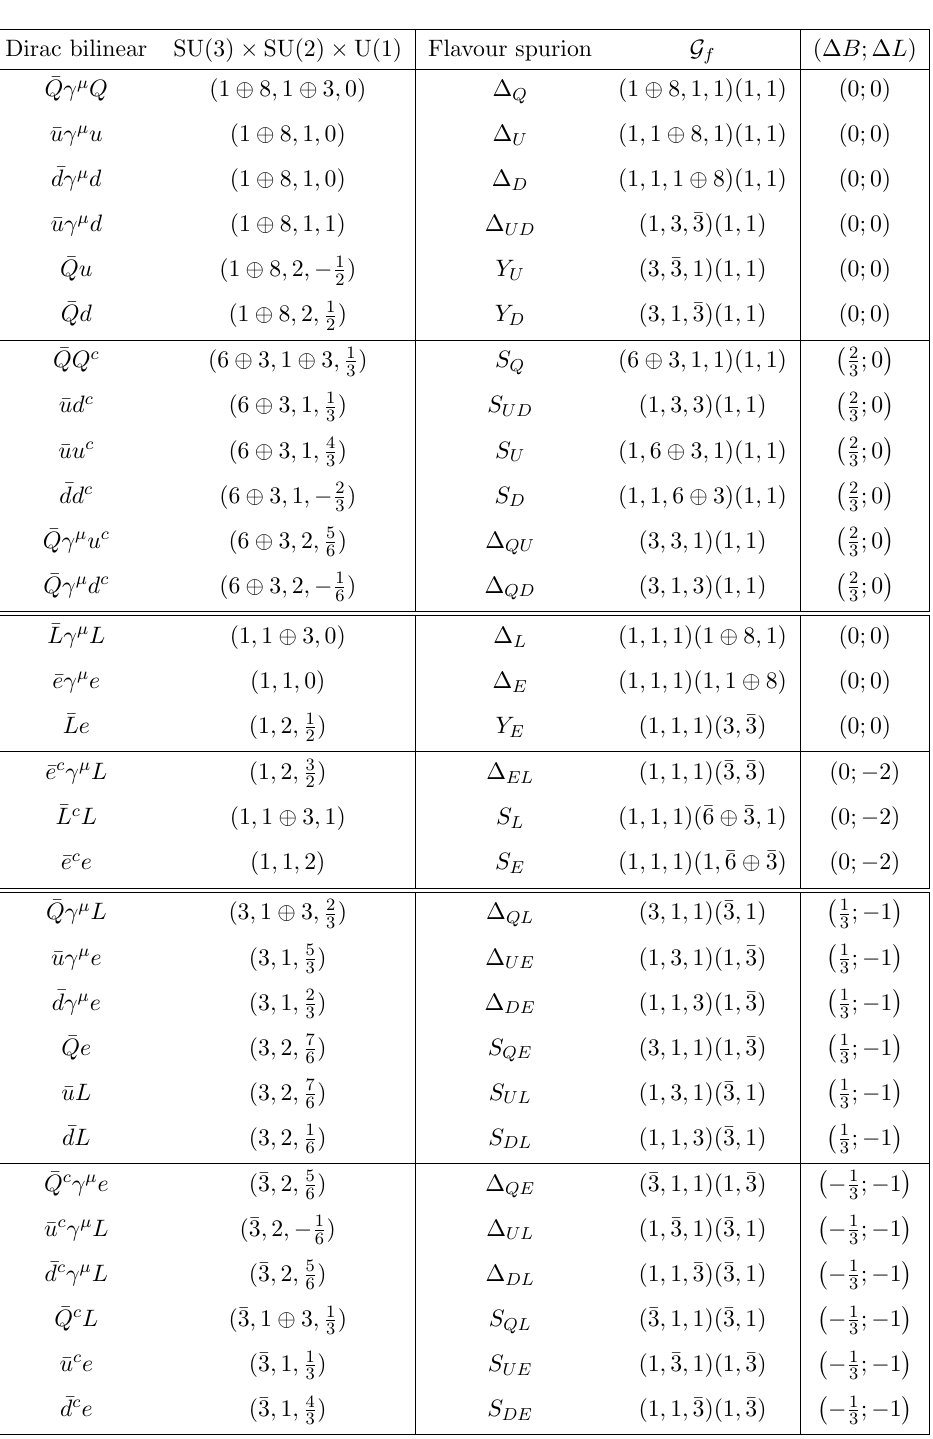
Table 2 . Dirac bilinears and their associated (cid:13)avour spurions, together with their quantum numbers under the SM gauge symmetries and the (cid:13)avour group G f . Baryon and lepton numbers of the spurions are also listed.